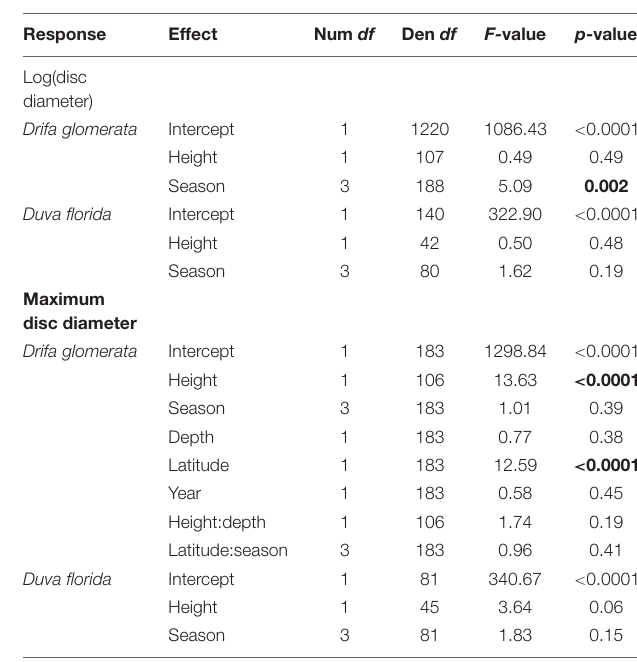
F-values obtained using the anova function in R. Num df nd Den df = numerator and denominator degrees of freedom, respectively. Values in bold represent significant p-values.